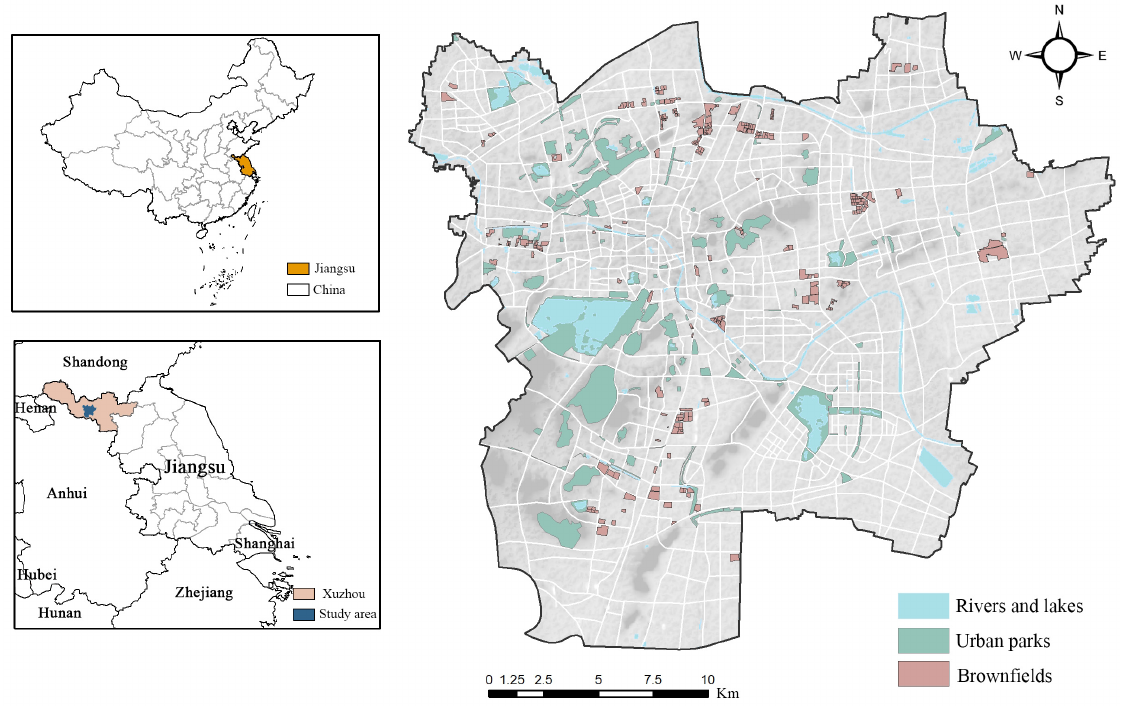
Figure 2. Location and brownfields of the study area.